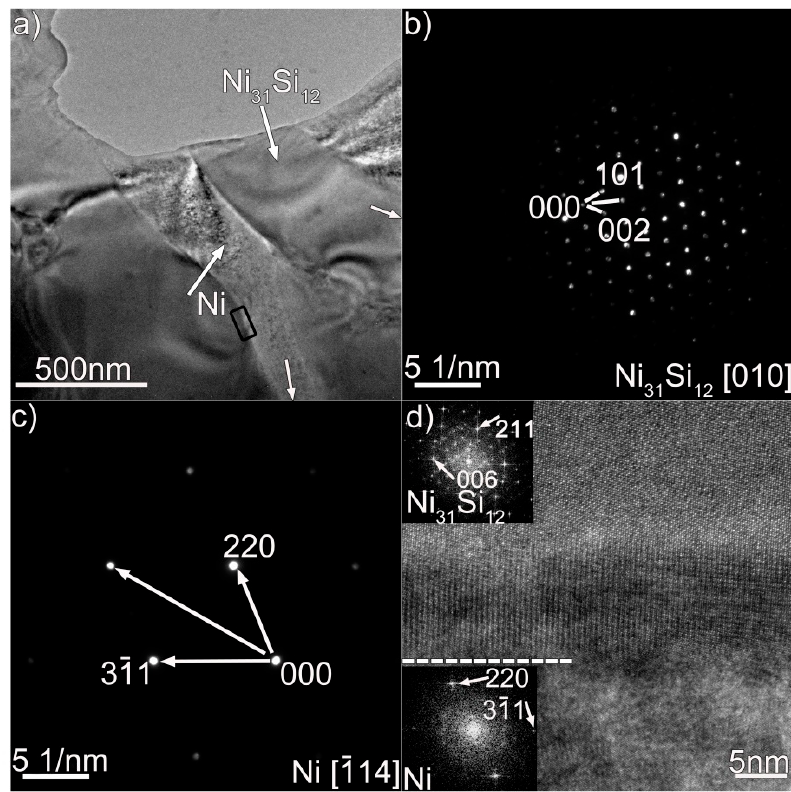
Figure 4. ( a ) Bright-field TEM micrographs of Ni 31 Si 12 and Ni in the coating, ( b , c ) SAED patterns of Ni 31 Si 12 and Ni in ( a ), and ( d ) HRTEM image of the Ni 31 Si 12 / Ni interface enclosed in black box in ( a ).